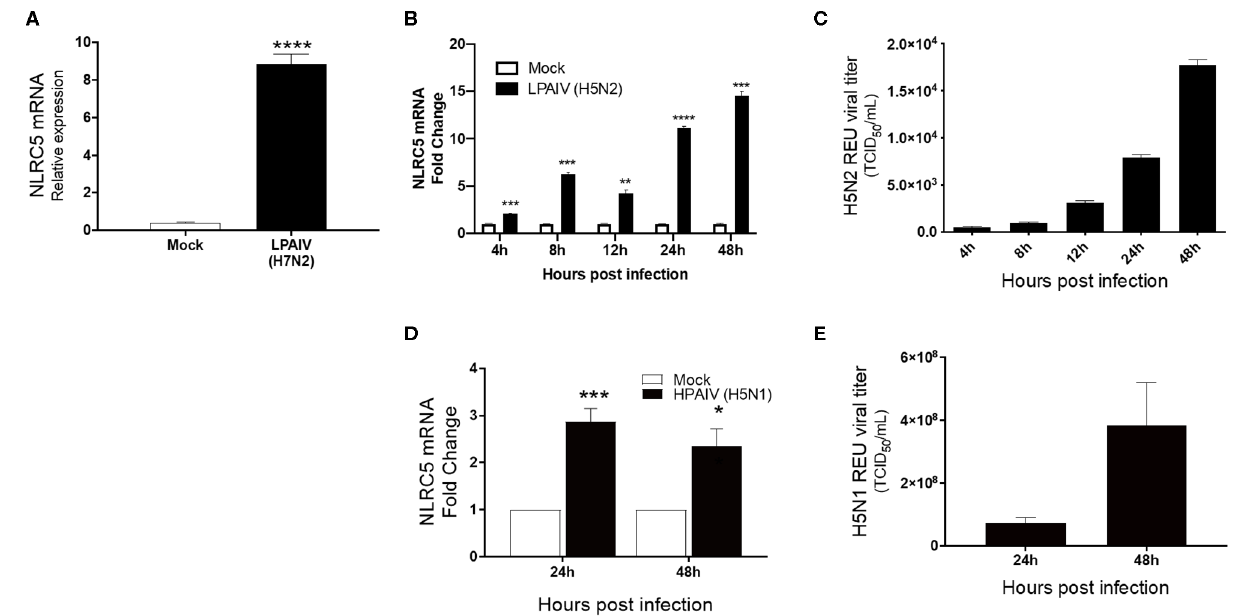
FIGURE 2 | Increase in NLRC5 mRNA and virus production in HPAIV- and LPAIV-infected chicken macrophages. Chicken macrophage MQ-NCSU cells were infected with the LPAIV H7N2, H5N2, or HPAIV H5N1. Total cellular mRNA and viral supernatant were collected at the designated timepoints. (A) NLRC5 mRNA levels at 24 hpi with H7N2 are shown. After LPAIV H5N2 infection, (B) NLRC5 mRNA levels and (C) virus production in the supernatant were measured between 4 and 48 hpi. After HPAIV H5N1 infection, (D) NLRC5 mRNA levels and (E) virus production in the supernatant were measured at 24 and 48 hpi. All NLRC5 mRNA levels were normalized to the housekeeping gene, HMBS. Data represents average of three biological replicates with error bars showing standard deviation. * p ≤ 0.05, ** p ≤ 0.01, *** p ≤ 0.001, **** p ≤ 0.0001.